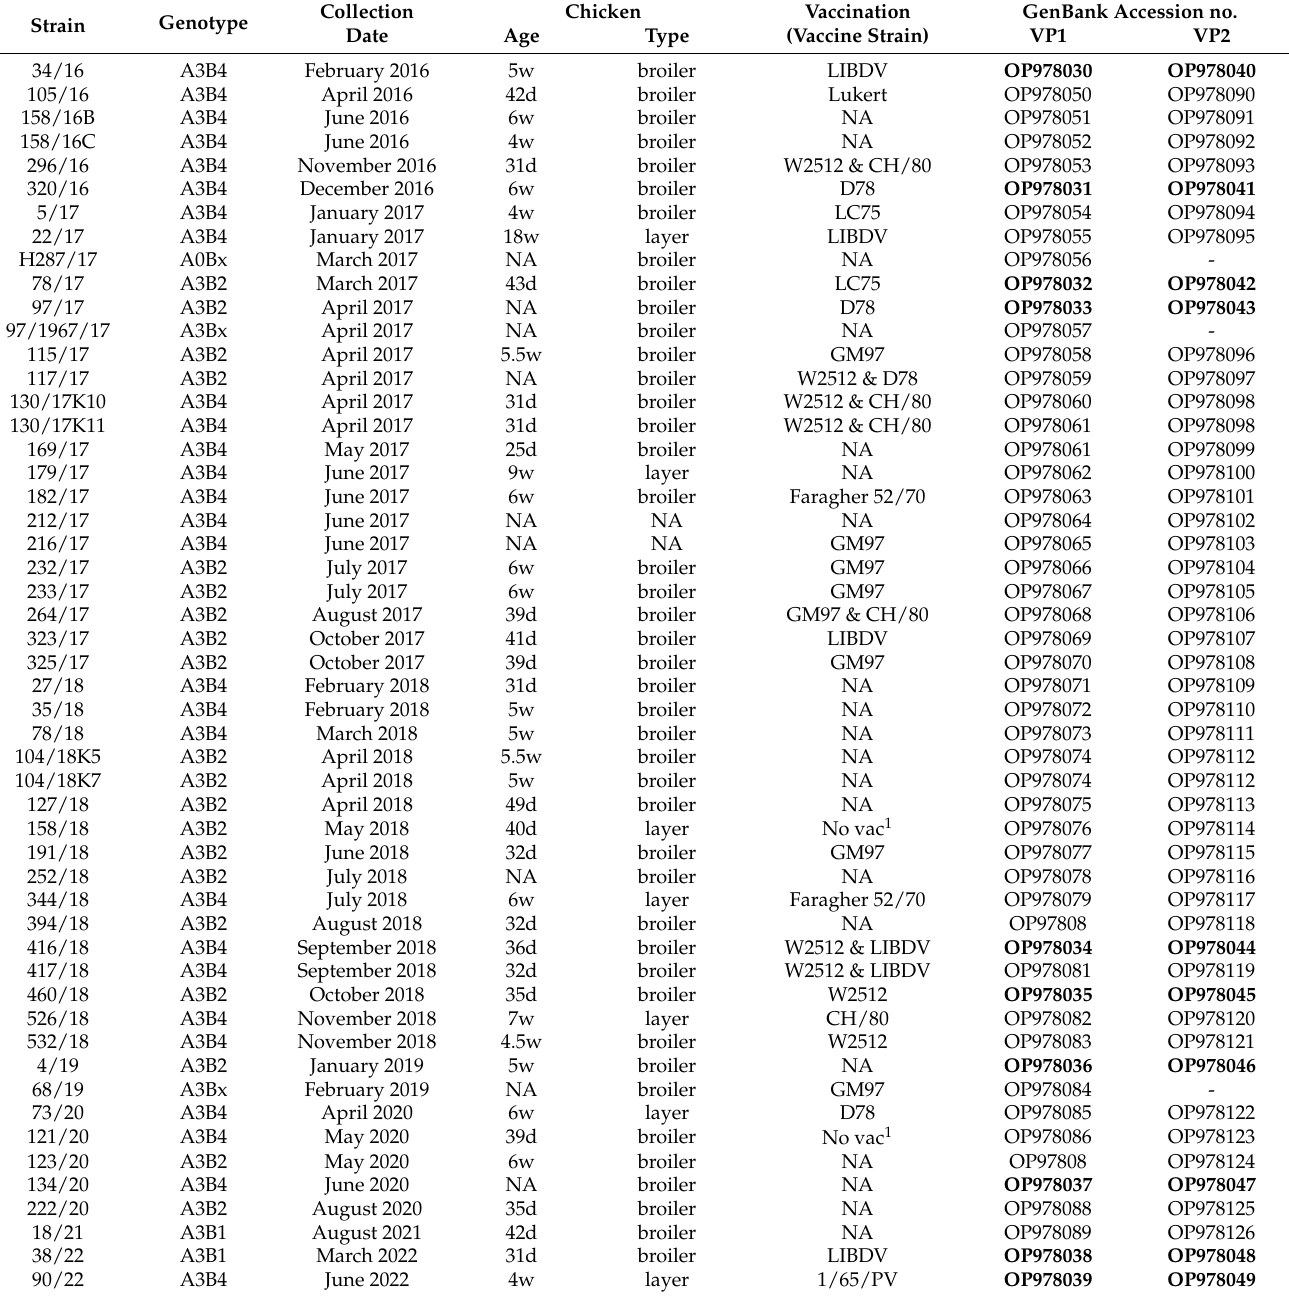
Table 2. List of field strains circulated in Poland